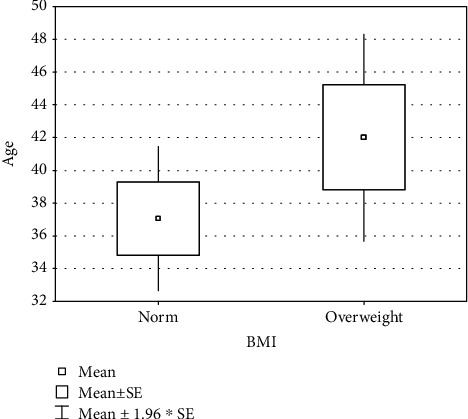
Comparison of the participants' age depending on the BMI values.